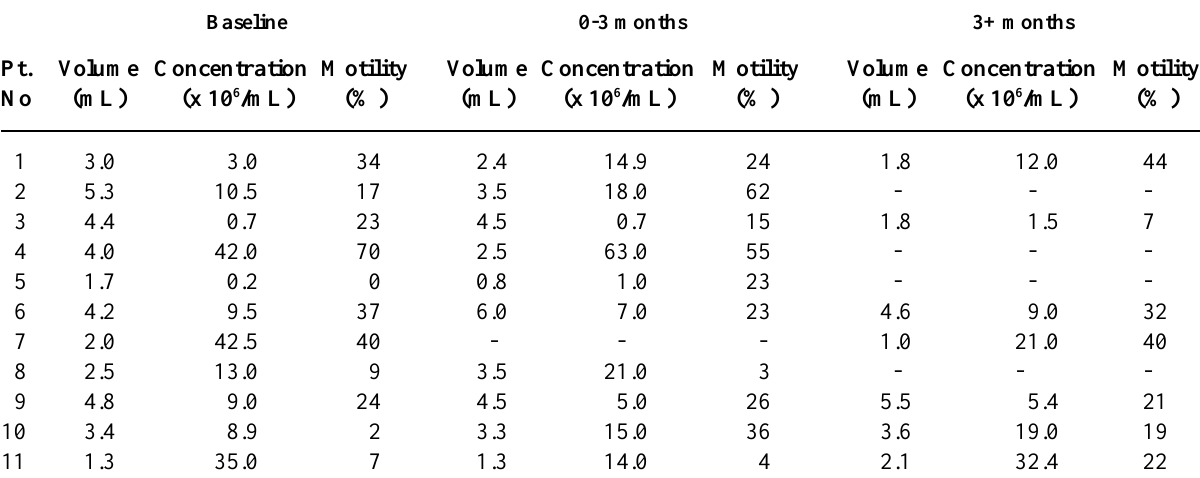
Table 3 – Semen parameters at baseline, 0-3 months post-intervention, and more than 3 months post-intervention